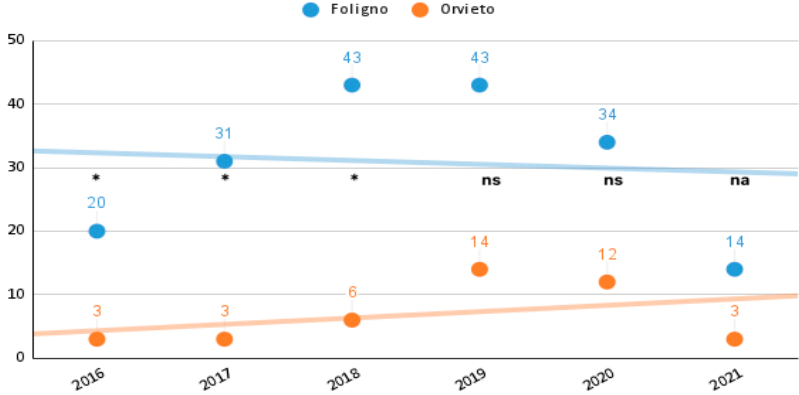
Figure 5. Number of acute ischemic stroke treated with tPA in the participating hospitals from 2016 to the first quarter 2021. * two-sided Fisher’s exact test with p value <0.05; ns: two-sided Fisher’s exact test non-significant p value; na: not applicable. Table 1. Patients characteristics on acute ischemic stroke admitted in the participating hospitals and treated with.v. tPA treatments from 2016 to first quarter 2021.